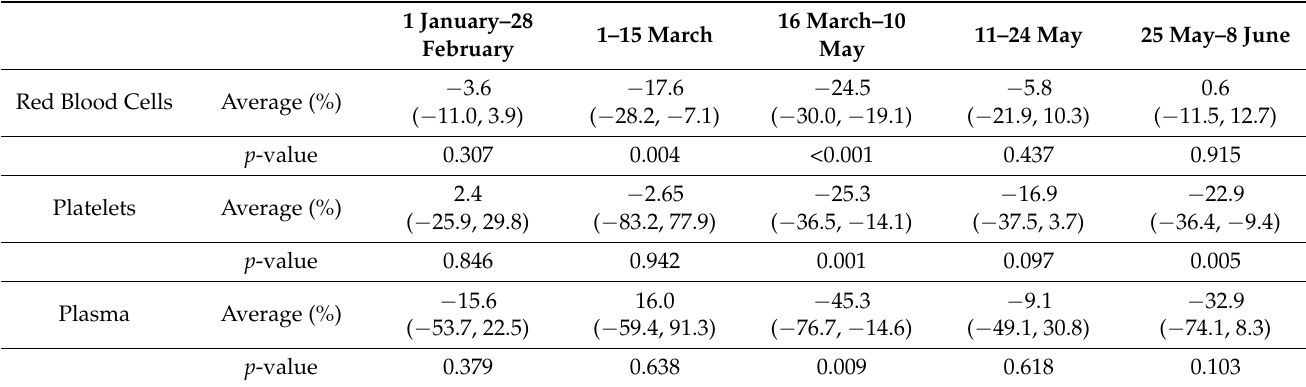
Table 3. Evolution of the accumulated consumption of red blood cells, plasma and platelets in hospital centers compared to the same period of the previous